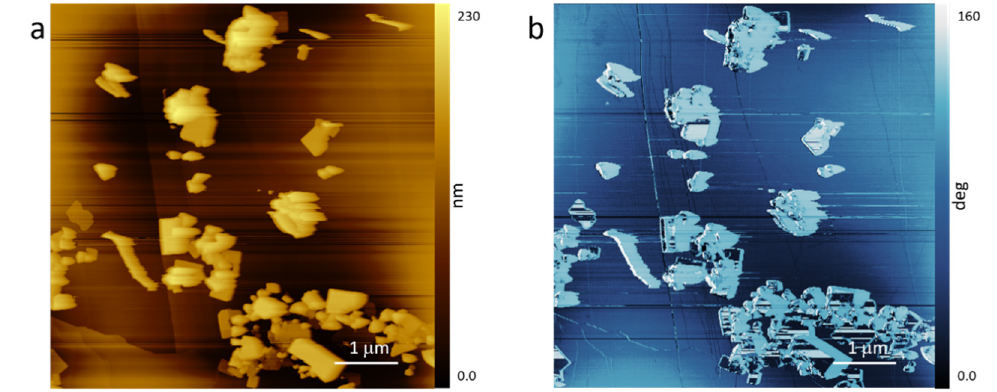
Figure 7. A (6 × 6) μ m 2 AFM image acquired on the H 2 Po 10 nm thick sample after the exposure to hydrochloric vapors: ( a ) topography; ( b ) phase-contrast image. The HOPG substrate is exfoliated along the vertical